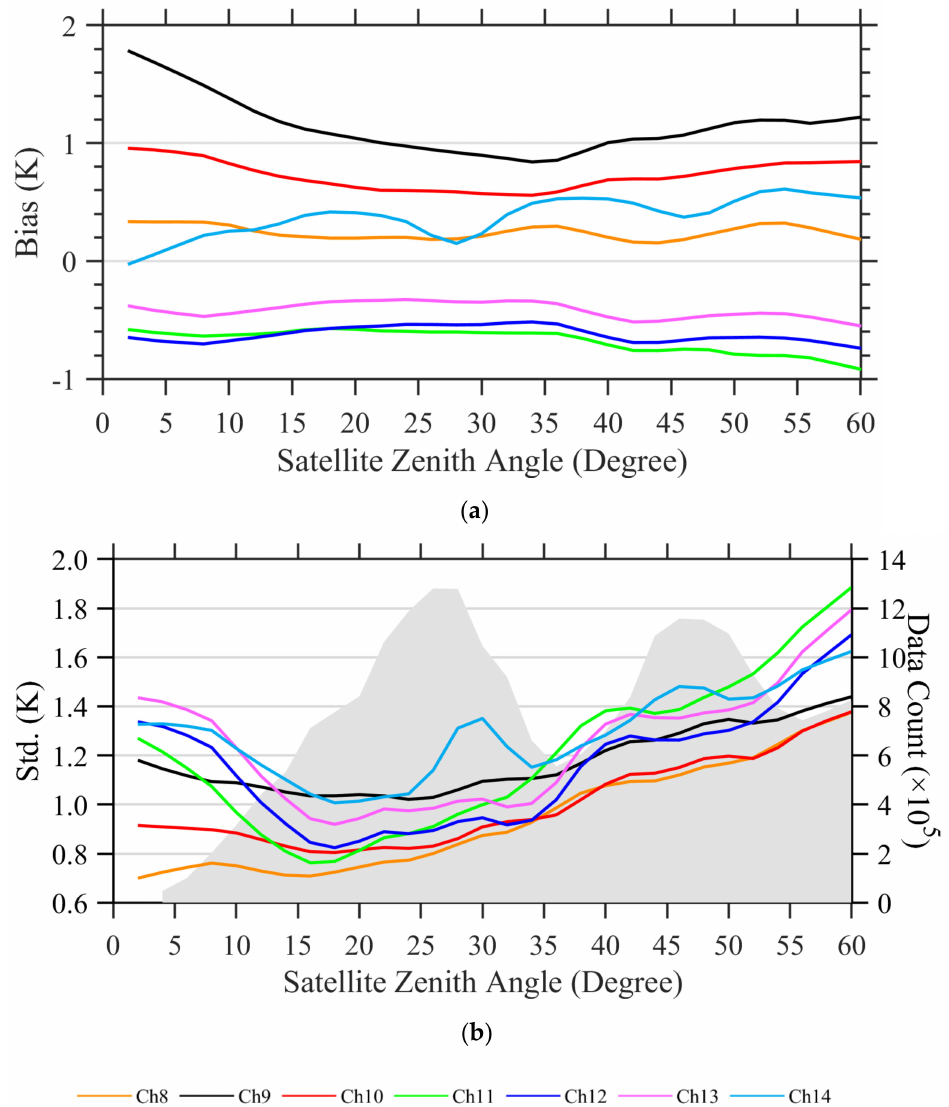
Figure 10. Variations of ( a ) biases and ( b ) standard deviations of OMB FNL with respect to satellite zenith angles for AGRI bands 8–14 over the ocean in January, April, July, and October 2019. Data counts calculated at 2 ◦ intervals are indicated by grey shading in ( b